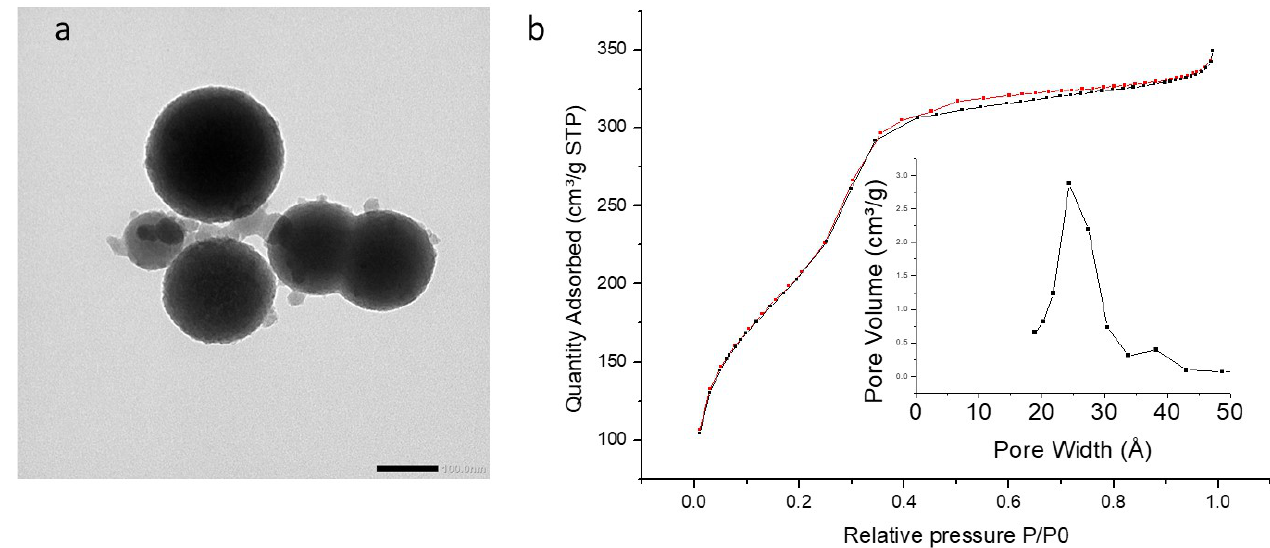
Figure 5. ( a ) TEM image of PyPMO 15 NPs scale bar 100 nm. ( b ) Nitrogen adsorption–desorption at 77 K. Insert BJH desorption (dV/dlog(w)) Pore Volume. Table 1. Size distribution, standard deviation values of PMO 1 NPs, pyPMO NPs, analyzed from TEM, specific surface area and pore sizes of PMO 1 NPs, pyPMO NPs analyzed from N 2 sorption experiments.